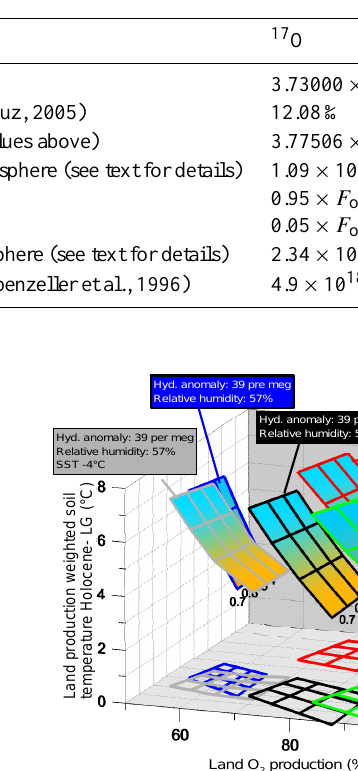
Fig. 2. Fluxes of land and ocean production relative to mod- ern (100%) for a range of C4 contributions (40–70%) and land production-weighted soil temperatures 4–7 ◦ C lower than modern. Blue (default scenario): relative humidity and 17 1 anomaly of pre- cipitation similar to modern (57% humidity and 39 per meg hy- drological anomaly). Relative to the default scenario the follow- ing parameters were modified: SST 4 ◦ C lower than modern (gray- lined flying carpet), relative humidity increased from 57% to 59% (black-lined), hydrological anomaly set to 0 (red-lined), and precip- itation δ 18 O 1‰ lighter relative to paleo ocean water (green-lined). Also shown are projections of the flying carpets onto the plane, at bottom, where there was no difference between Holocene and Last Glacial Maximum temperatures. Note: all calculations for this graph are strictly for a LGM situation (Table 4). It is not possible to extract results for a Holocene situation from this